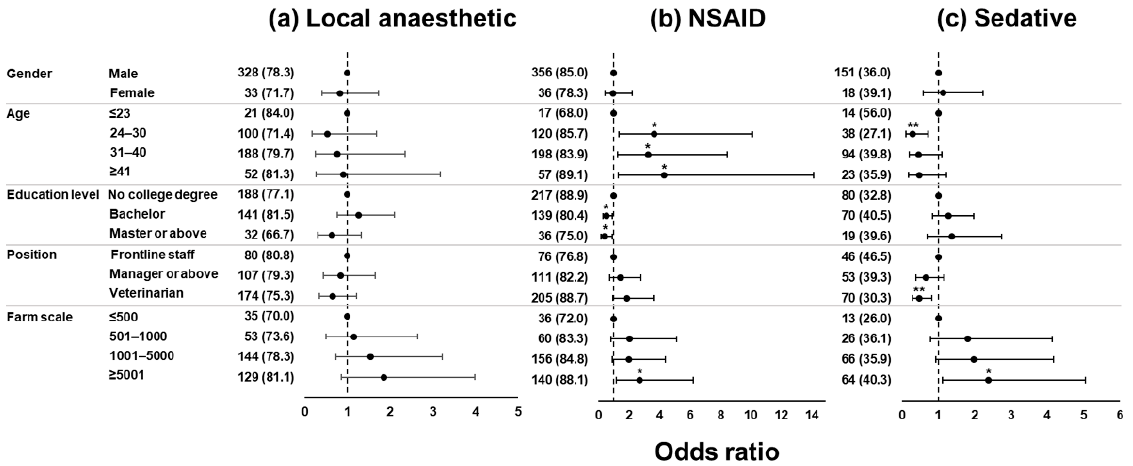
Figure 3. Summary of the answer to the multiple-response question asking the respondents to choose which kind(s) of analgesics they would use from three options: local anaesthetic (LA), non-steroidal anti-inflammatory drug (NSAID), and sedative (S).